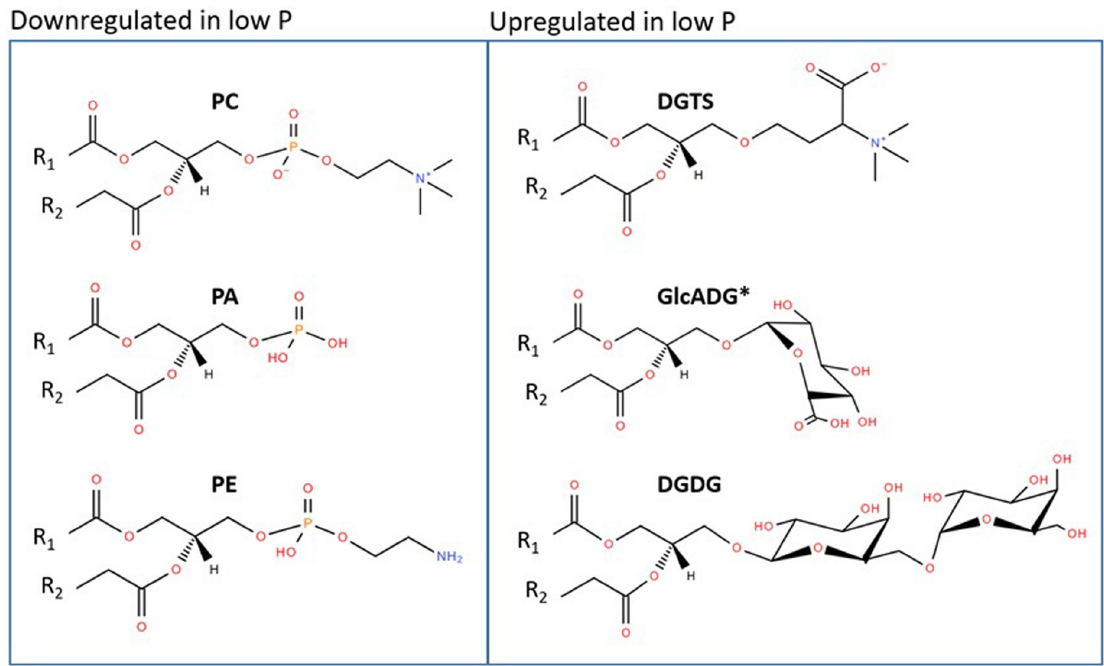
Fig 2. Examples of downregulated phospholipids that are key lipid species within the cell membrane, and significantly upregulated lipids that do not contain phosphorus. Lipid acronyms are defined as follows: phosphatidylcholine (PC), phosphatidic acid (PA), phosphatidylethanolamine (PE), diacylglyceryltrimethylhomoserine (DGTS), glucuronosyldiacylglycerols (GlcADG), and galactolipid digalactosyldiacylglycerol (DGDG). � for GlcADG only a few molecular lipid species were significantly